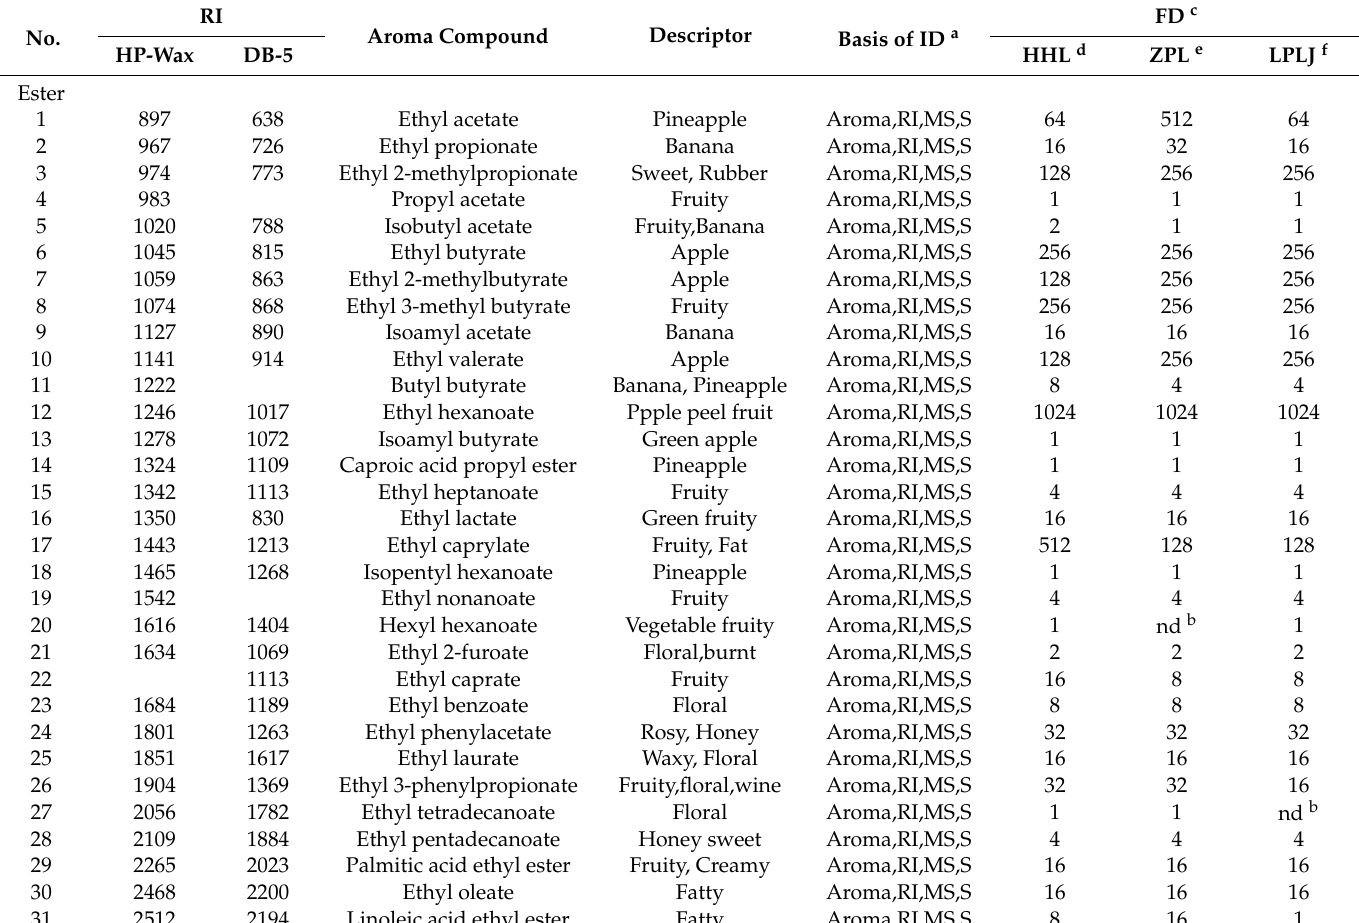
Table 1. Aroma compounds identified by gas chromatography-olfactometry (GC-O) in three